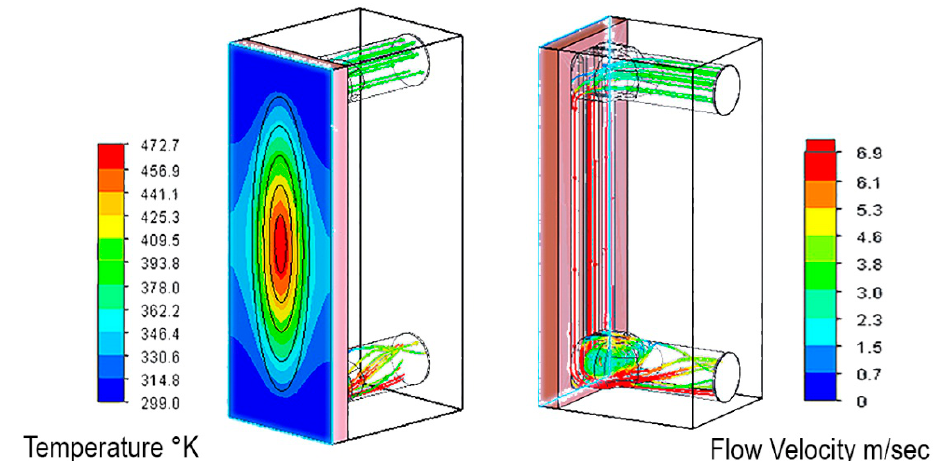
Figure 9. Flow and thermal simulation showing the water trajectories and velocity in m/sec (on the right ) and surface temperature contours in degrees K (on the left ).